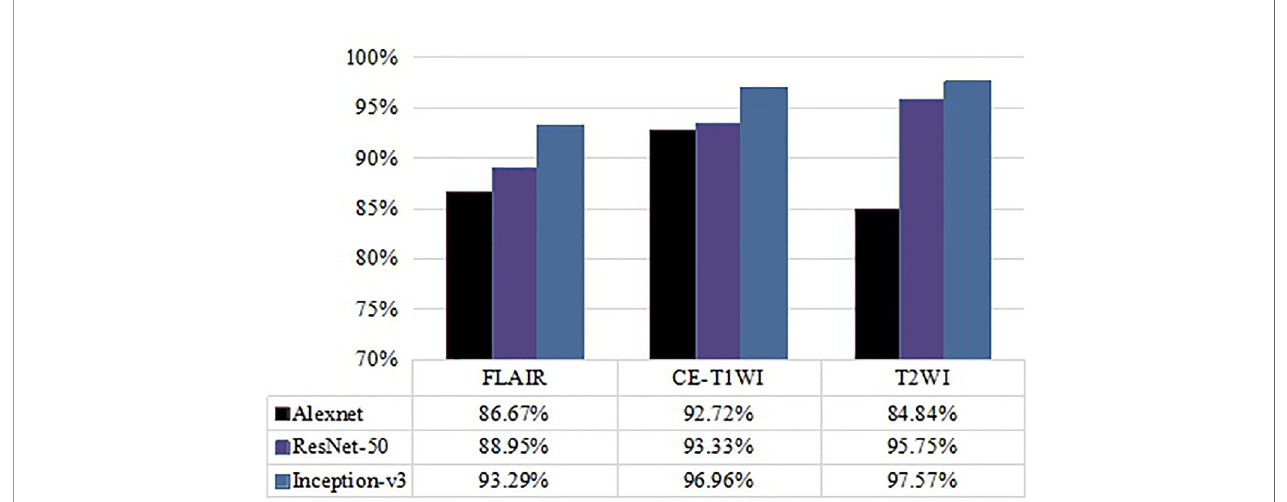
FIGURE 3 | Comparison of accuracy of classi fi cation performance with Alexnet, ResNet-50, and Inception-v3 on three single MRI